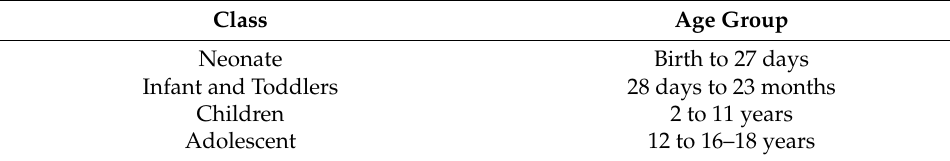
Table 1. Classification of pediatric age categories [10].